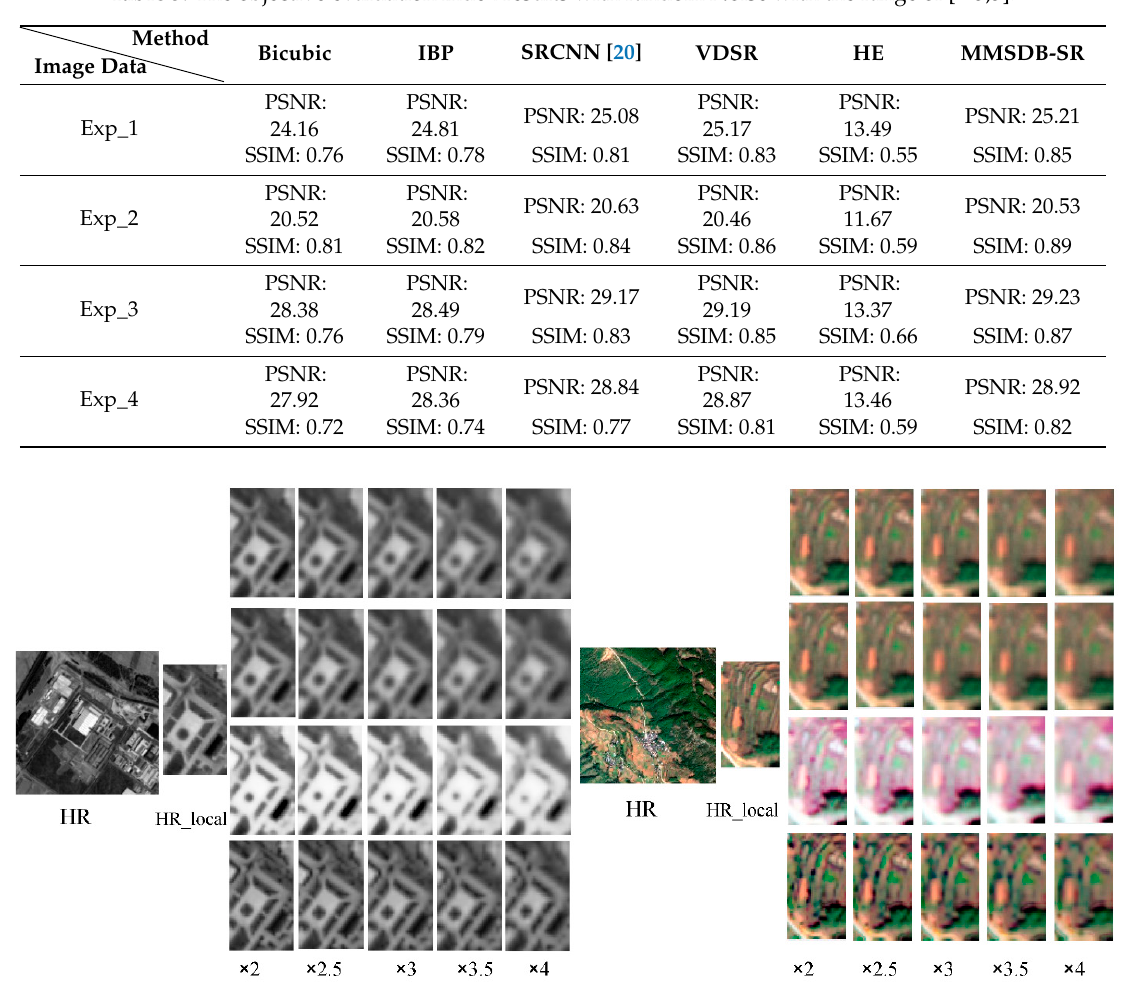
Figure 5. Different up-scaling factor SR reconstruction (SRR) results. The first layer is the SRR result based on Bicubic, the second layer is the SRR result based on IBP, the third layer is the SRR result based on HE, the fourth layer is the SRR result based on MMSDB-SR.